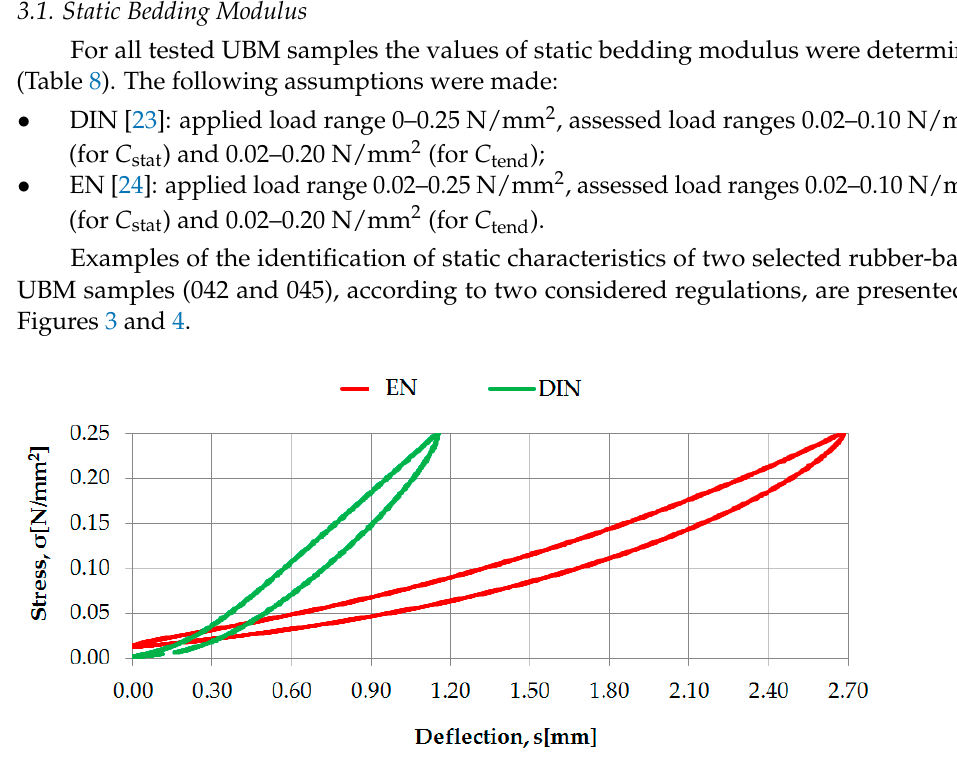
Figure 3. Static characteristics of UBM 042 determined according to DIN [23] and EN [24].